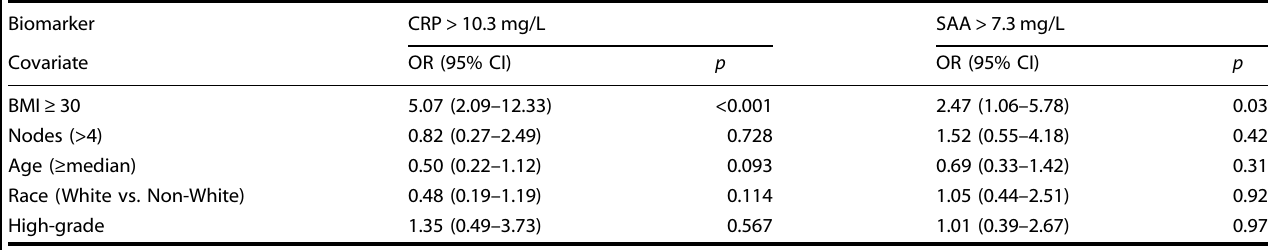
Table 5. Associations of covariates with elevated in fl ammatory biomarkers (HER2 − group only). Biomarker